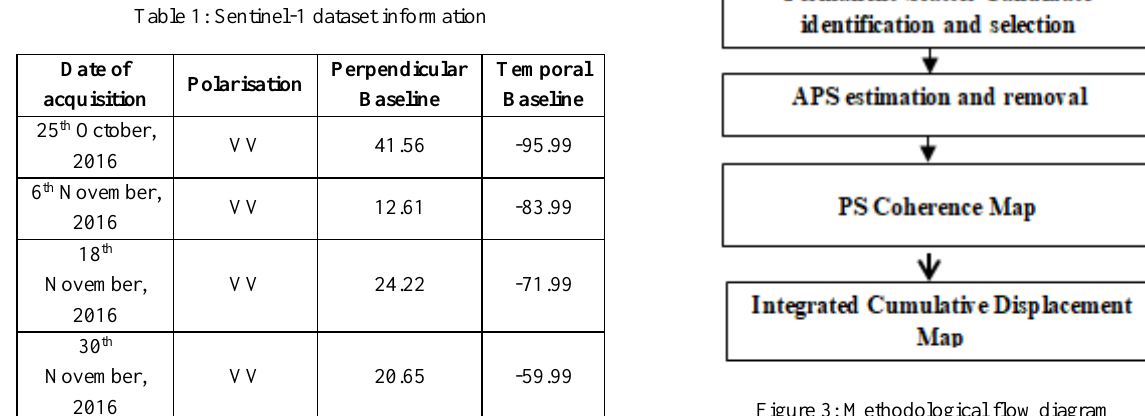
Figure 3: Methodological flow